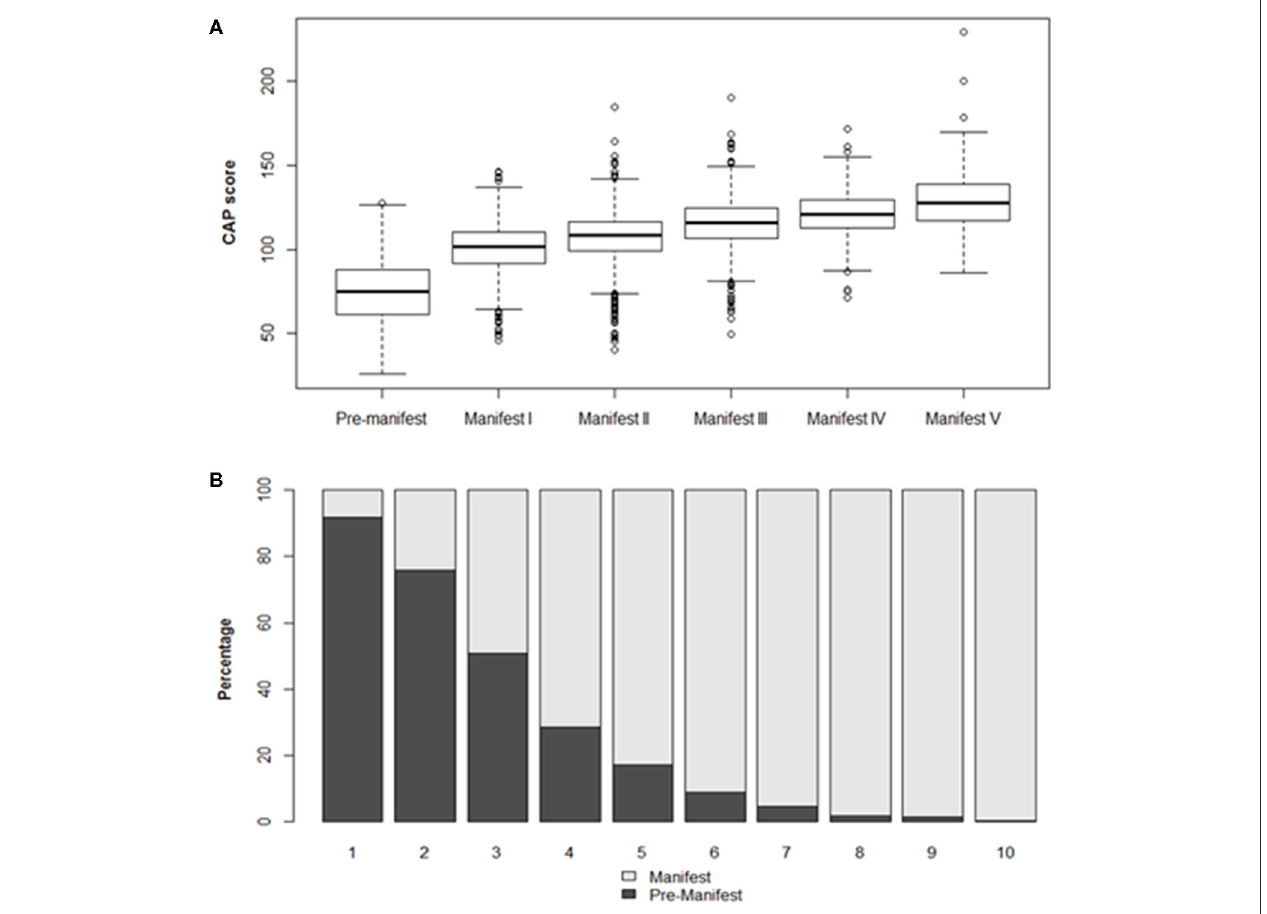
FIGURE 1 | Participant characteristics by disease stage at baseline visit. (A) CAP score distribution by disease stage (TFC defined). Boxes indicate interquartile range (IQR), spanning the 25–75th percentile. Horizontal lines indicate median values. Whiskers indicate 25th percentile minus 1.5*IQR (lower) and 75th percentile plus 1.5*IQR (upper). Observations beyond these thresholds are indicated by open circles. (B) Manifest status by CAP score